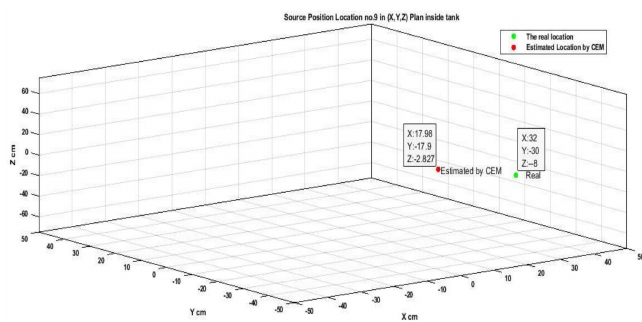
Figure 9. Actual and estimated PD source at position No.9 in (x,y,z) plane,